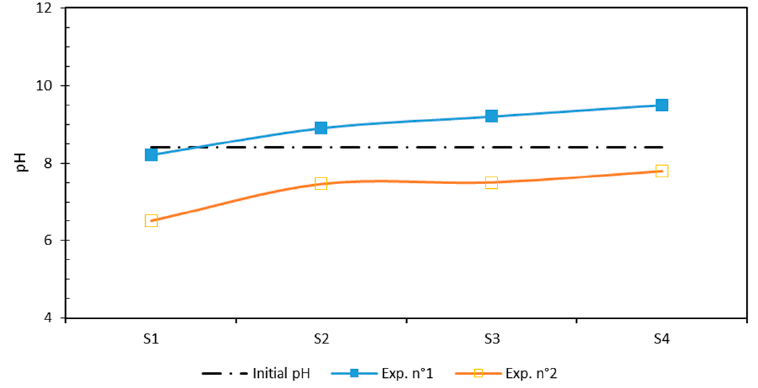
Figure 3. Distribution of pH after EKR test.